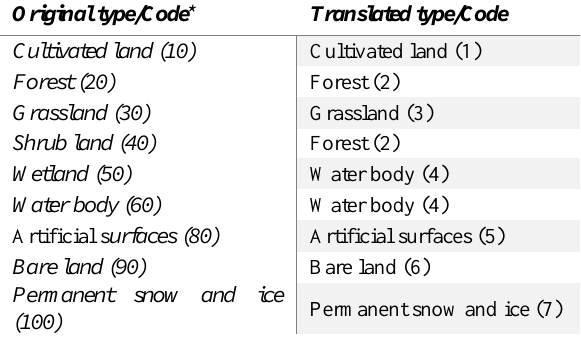
Table 1. Translation table for class merge